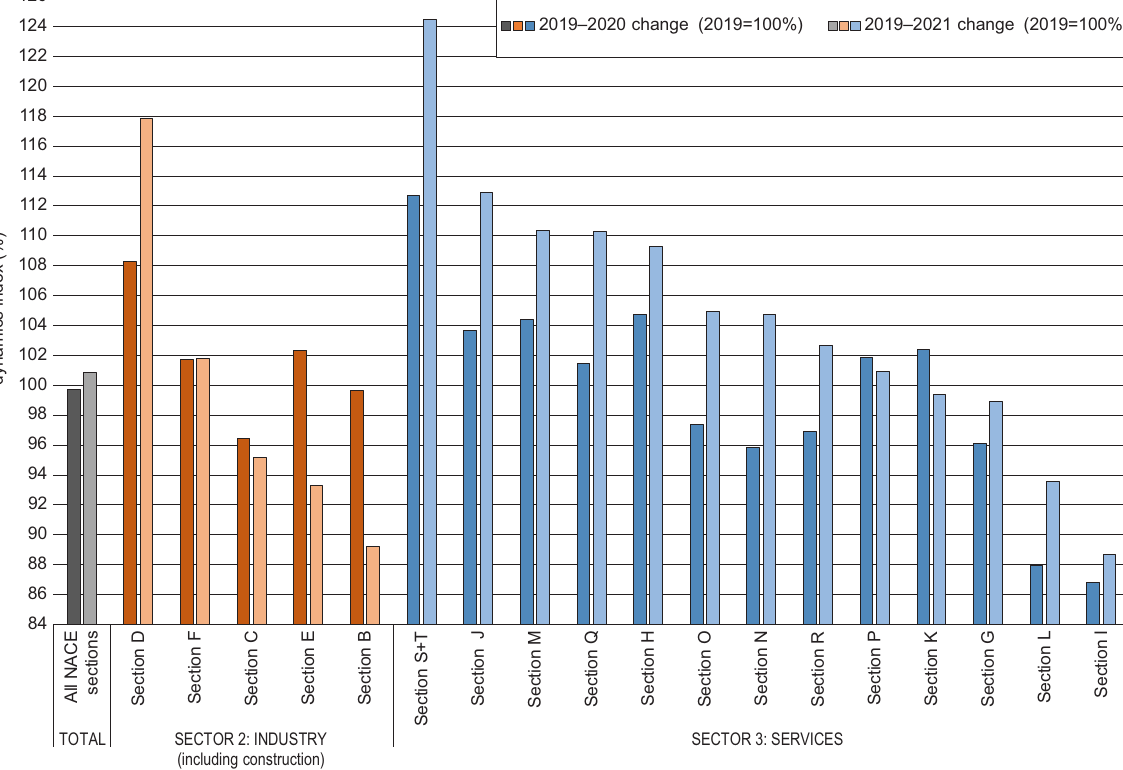
Fig. 2. Employment growth in industry and services by the NACE section in the period of 2019–2021 in Poland (2019 –